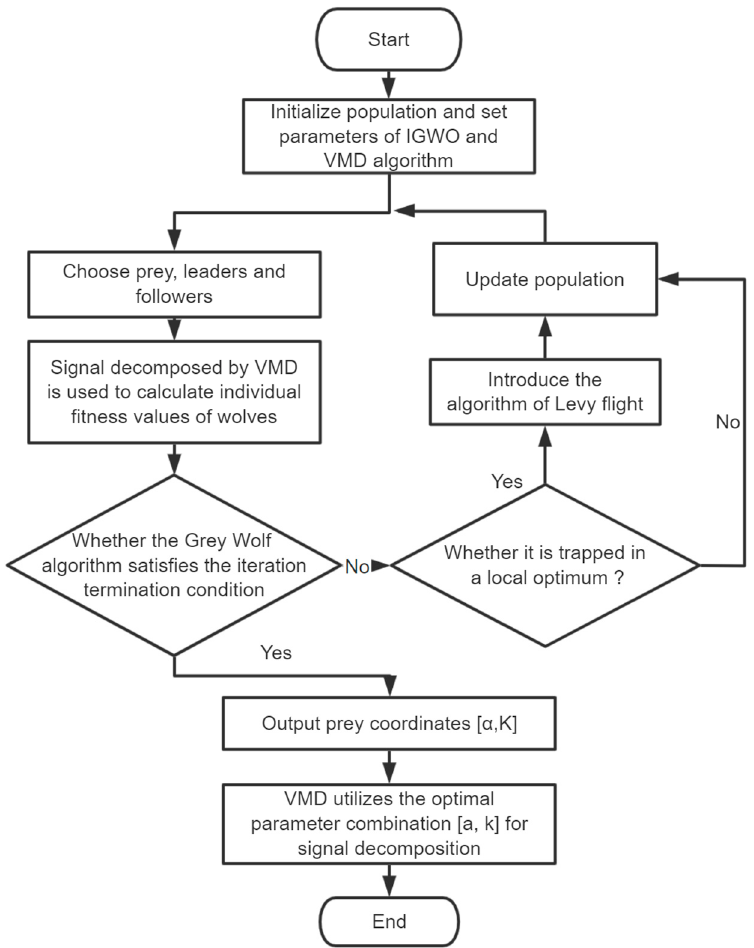
Figure 3. IGVMD algorithm flow chart.